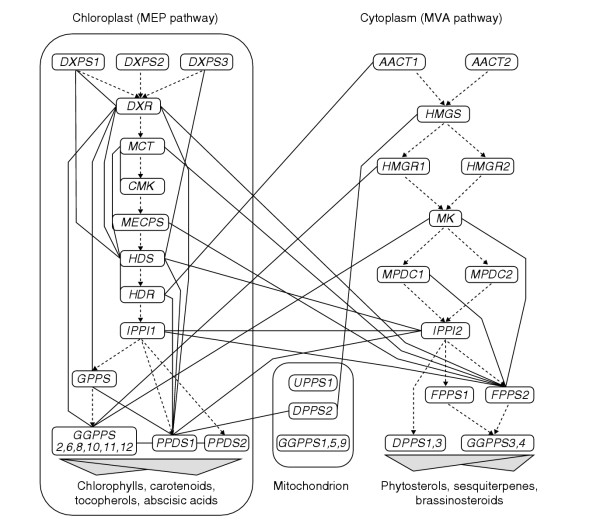
Bootstrapped GGM of the isoprenoid pathway with a cutoff at 0.8. The solid undirected edges connecting individual genes (in boxes) represent the GGM. Dotted directed edges mark the metabolic network, and are not part of the GGM. The grey shading indicates metabolic links to downstream pathways.